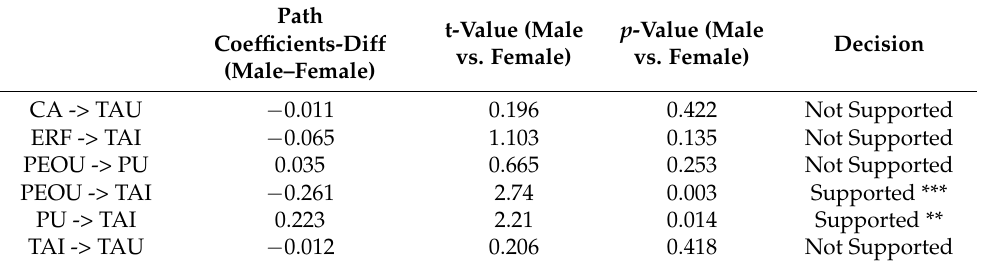
Table 6. Parametric